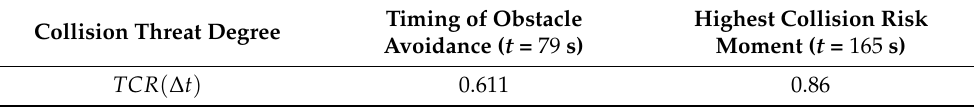
Table 6. Critical moment collision threat degree assessment results.